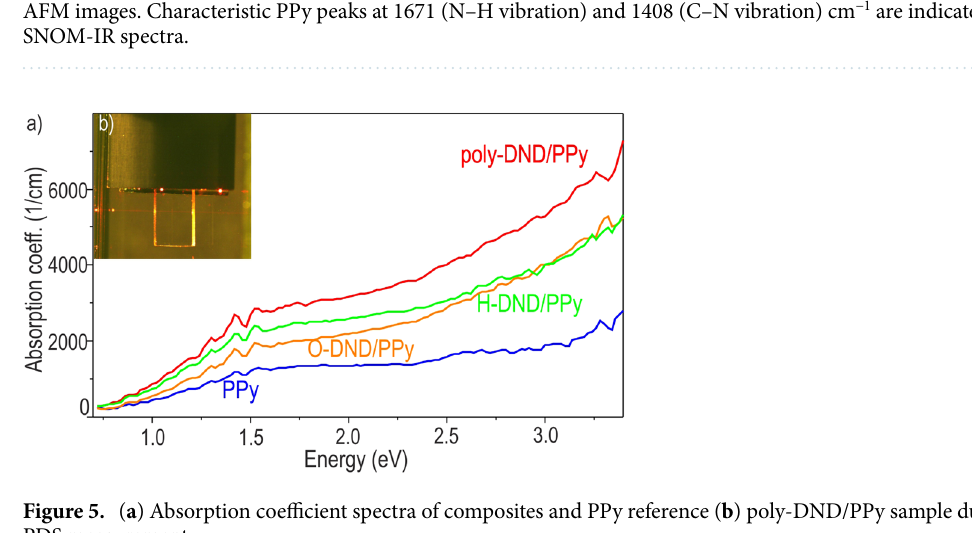
Figure 5. ( a ) Absorption coefficient spectra of composites and PPy reference ( b ) poly-DND/PPy sample during PDS